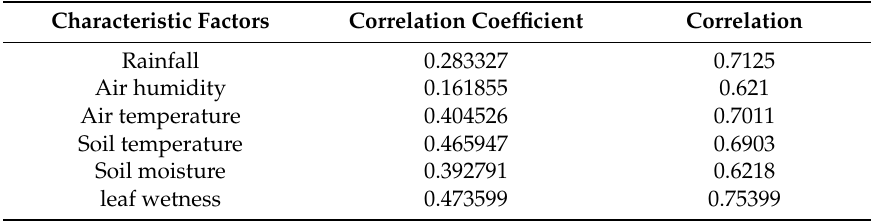
Table 3. Pearson Correlation Coefficient and Grey relational analysis for Southern China Vegetable Pest Data Set Computation